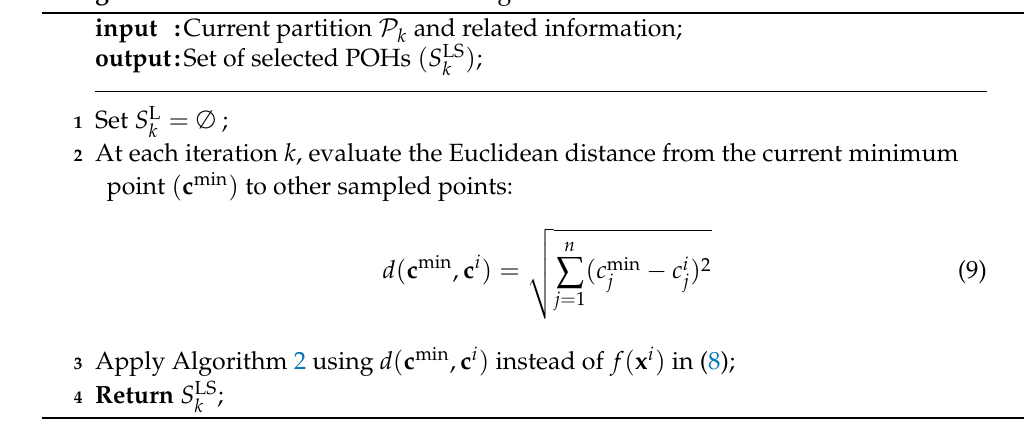
Algorithm 3: Pareto selection enhancing the local